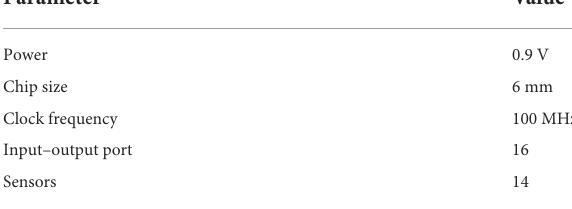
TABLE 1 Simulation parameters of intelligent mobile health monitoring system